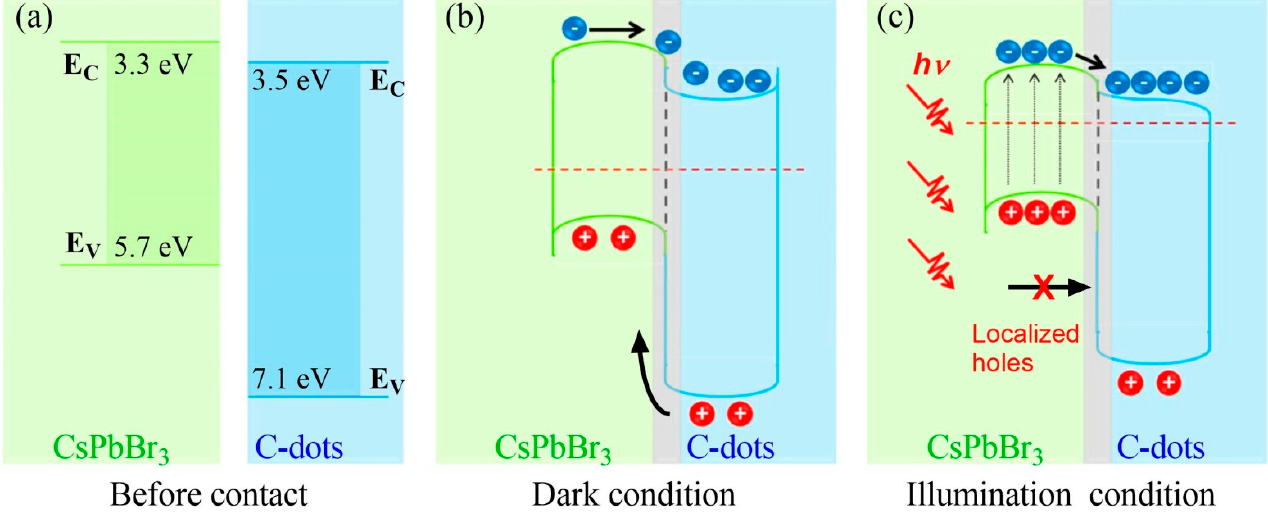
Figure 6. The energy band alignment of C-dot and CsPbBr 3 perovskite materials before contact ( a ), in the dark ( b ), and under illumination conditions ( c ).